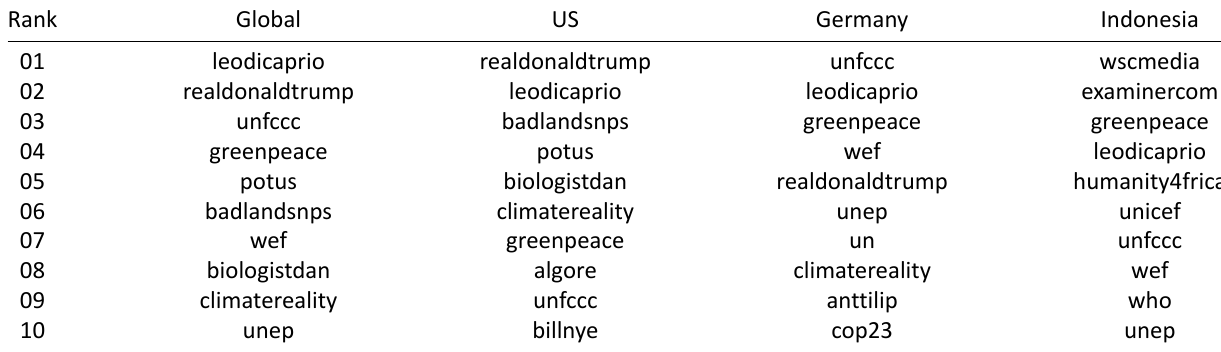
Table 1. Top 10 users measured by indegree for the global network and selected country subgraphs. Rank